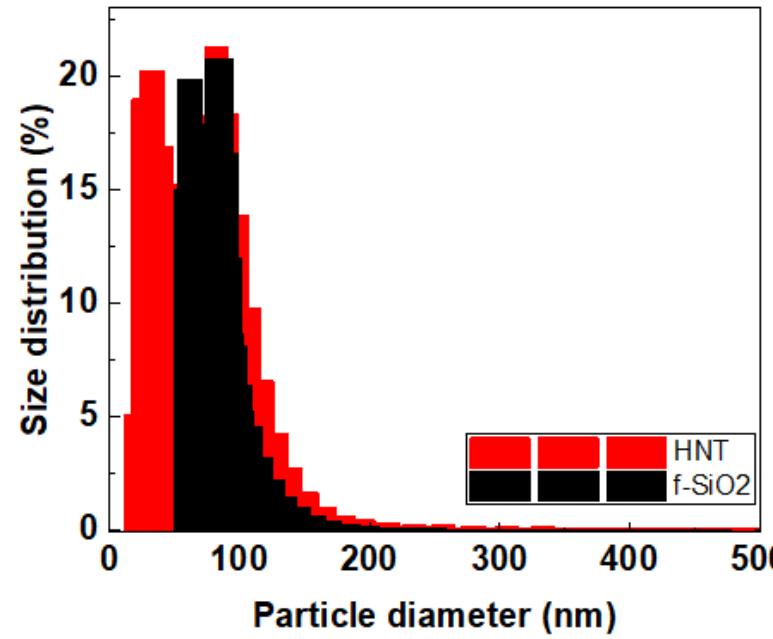
Figure 1. Dynamic light-scattering (DLS) results obtained for HNT and functionalized silica.